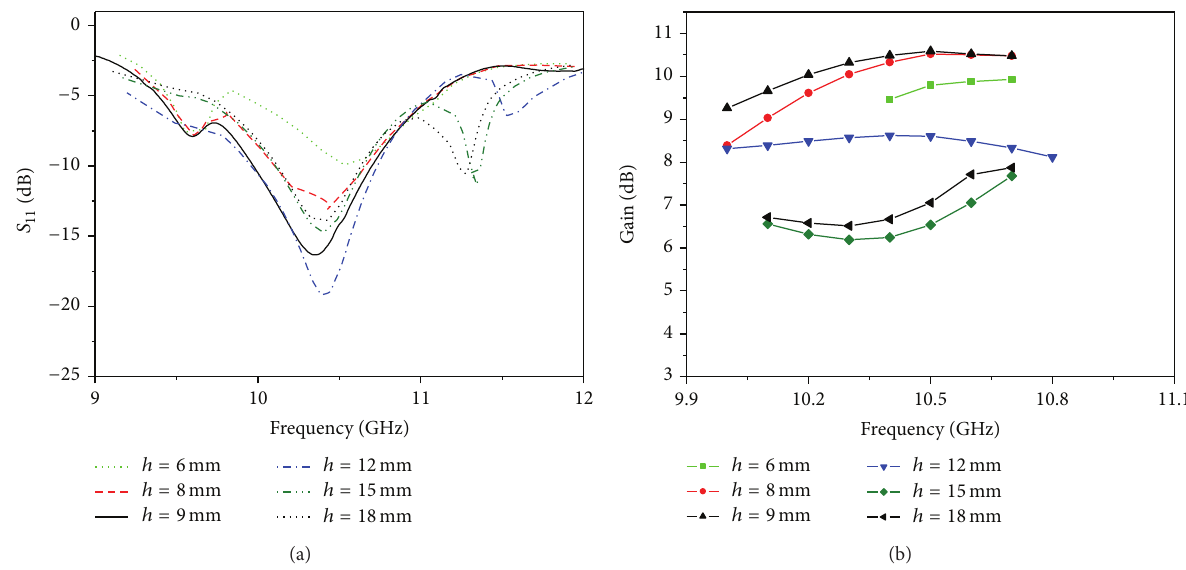
Figure 5: The performance of the proposed narrowband antenna with the ZIM cover for different distances ℎ , (a) the reflection coefficients and (b) the antenna gains.